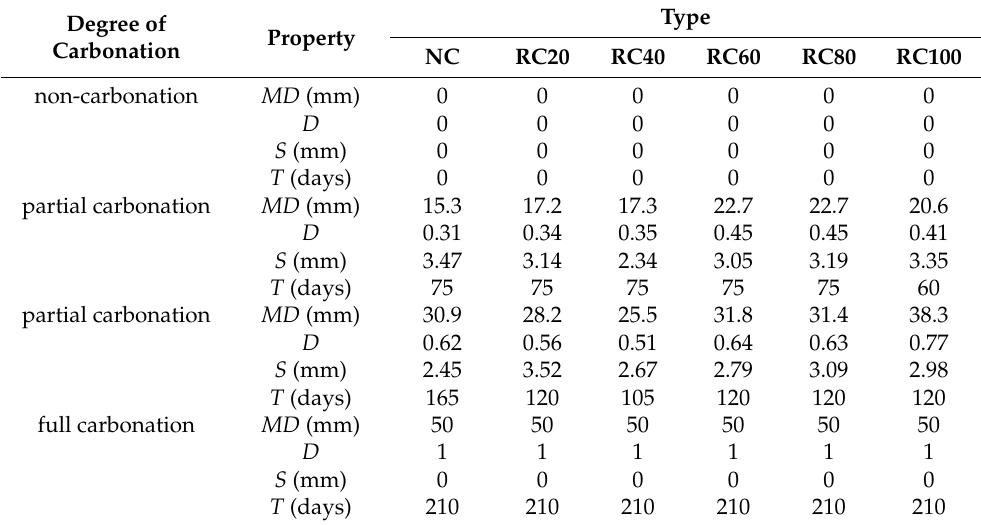
Table 4. Carbonation test results of concrete